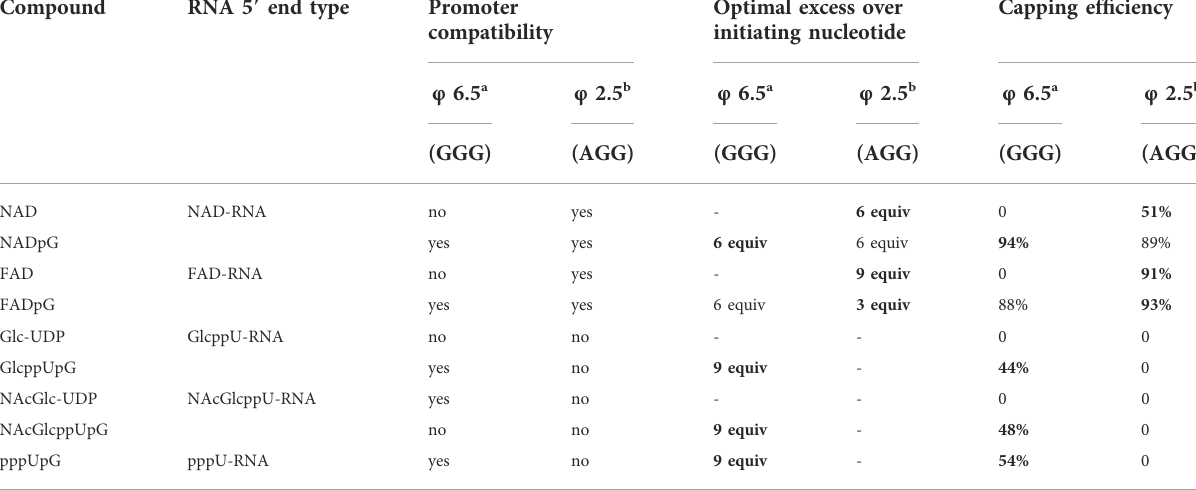
TABLE1SummaryofRNAcappingef fi cienciesfortheinitiationofdifferentnucleotidesasafunctionoftheT7promoterpresentintheDNAtemplate.